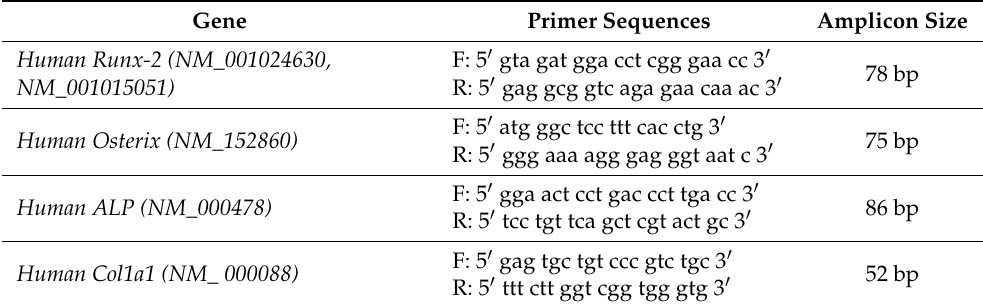
Table 2. Primers used for real-time q-PCR. Gene Primer Sequences Amplicon